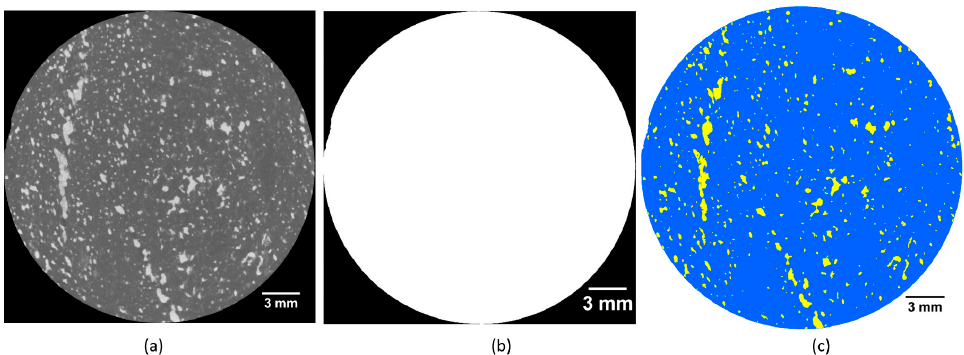
Figure 5. Otsu thresholding, showing: ( a ) Original slice of drill core stack from µCT; ( b ) global thresholding with Otsu; and ( c ) multi-level thresholding with Otsu. It can be seen that directly using global thresholding will only intercept the drill core volumes from the background; multilevel thresholding is needed to extract the mineral grains from the drill core.